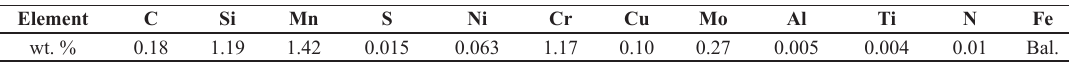
Table 1. Chemical composition of the experimental DIN 18MnCrSiMo6-4. Element